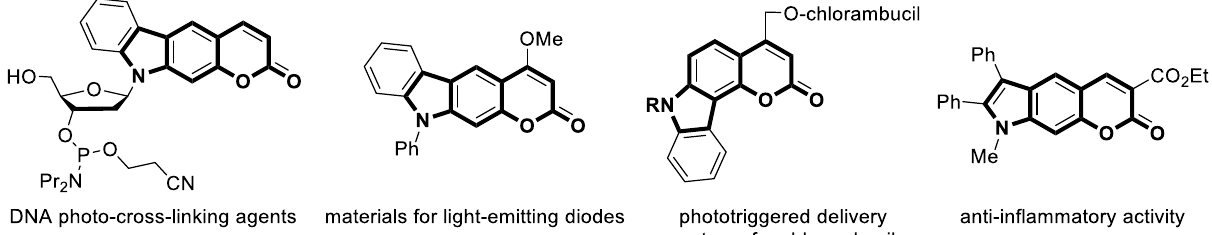
Figure 1. Some important pyranocarbazole and pyranoindole derivatives.